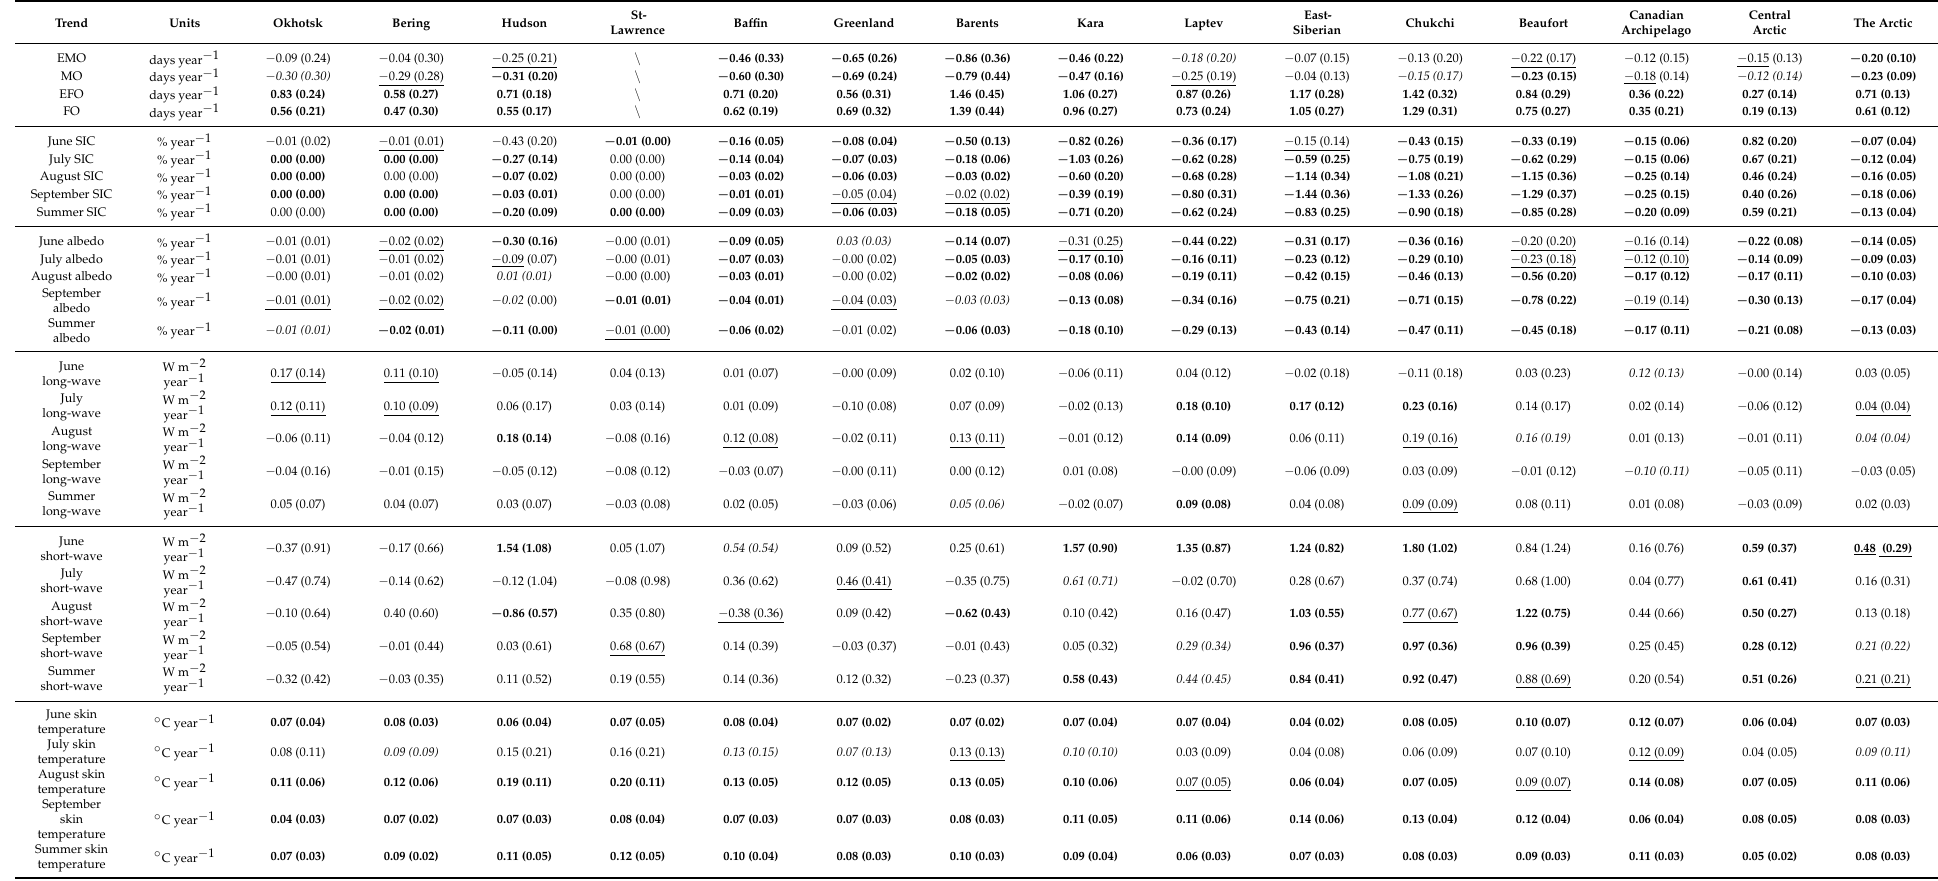
Table 1. Trends in melt timing, albedo, net long-wave radiation, net short-wave radiation, and skin temperature over the Arctic and its sub-regions for 1982–2018. The italic, underlined, and bold values indicate the trends that are significant at the 90%, 95%, and 99% confidence levels. Uncertainties (in parentheses) of the trends were estimated at 95% confidence